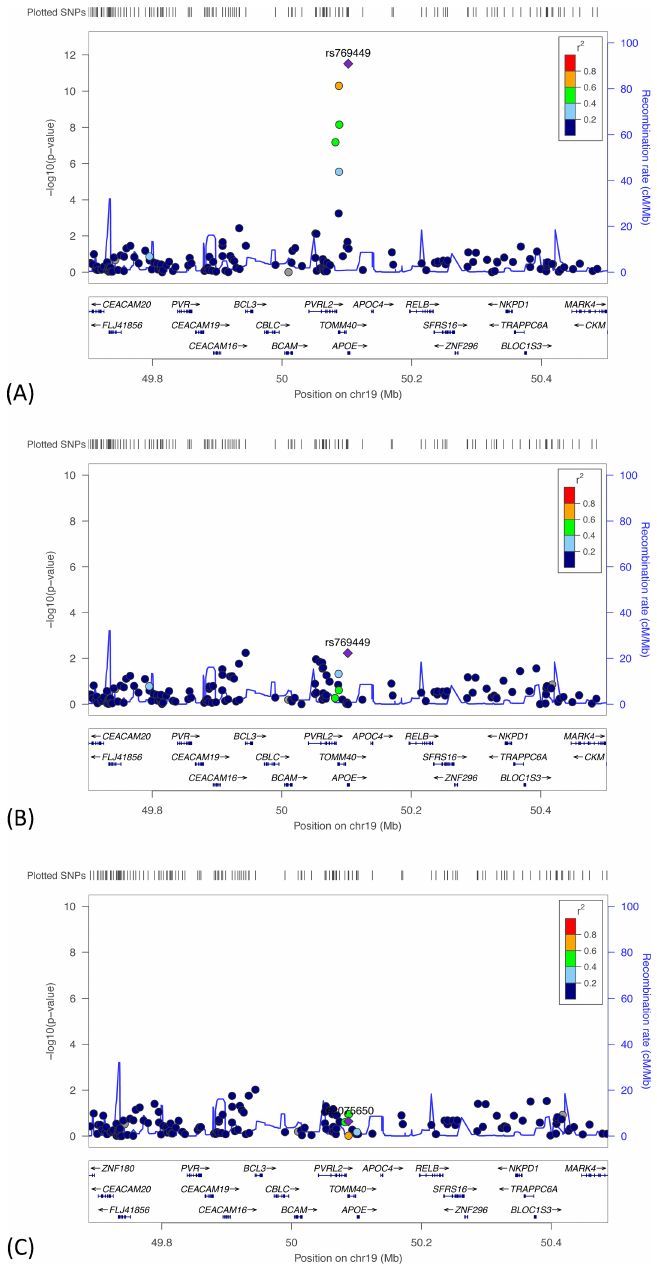
Fig 4. Regional plots showing meta-analyses results for rDR-L. (A) Results with the top associatedSNP in the APOE regionlabeled.Two conditional meta-analyses were performed for rDR-L, (B) estimatingthe association with the APOE SNP shown (rs769449), conditioningon the top TOMM40 SNP (rs2075650); and (C) estimating the associationwith the TOMM40 SNP shown(rs2075650), conditioningon the top APOE SNP (rs769449). The y-axis shows -log 10 P-values; x-axis shows positionof geneson chromosome19 with SNPs 400-kbin both directions of the SNP of interest. The diamondrepresentsthe top SNP of interest. The circles representeach genotyped SNP in this region; the circle color indicatespairwiselinkagedisequilibrium (LD) in relationto the top SNP (calculated from hg19/1000 Genomes Nov 2014 EUR). The solid (blue) line indicates the recombination